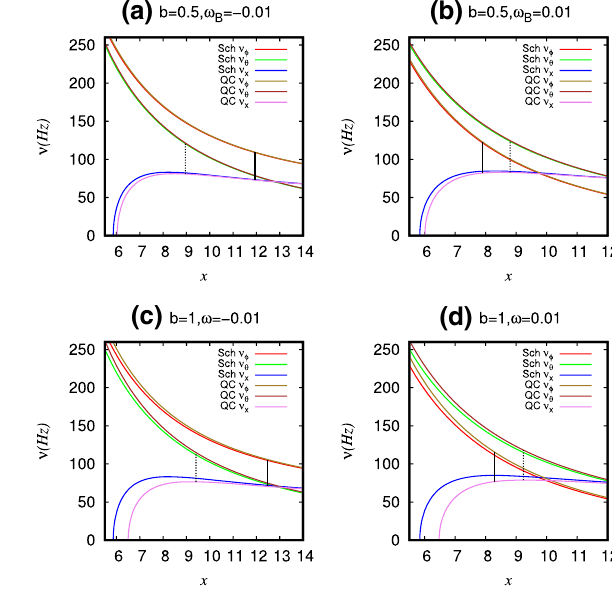
Fig. 14 The epicyclic frequencies for quantum-corrected Fig. 12 The probability density functions of the initial state distribu- Schwarzschild black holes (“QC”) and Schwarzschild ones (“Sch”) tionswithrespectto x , E , l and U t inquantum-correctedSchwarzschild 0 immersed in an external uniform magnetic field. Black solid vertical black holes lines denote the positions of 3:2 resonance in between ν x and ν ϕ , black dotted vertical lines denote the positions of 3:2 resonance in between ν θ and ν x and black dashed vertical lines denote the positions of 3:2 resonance in between ν θ and ν ϕ